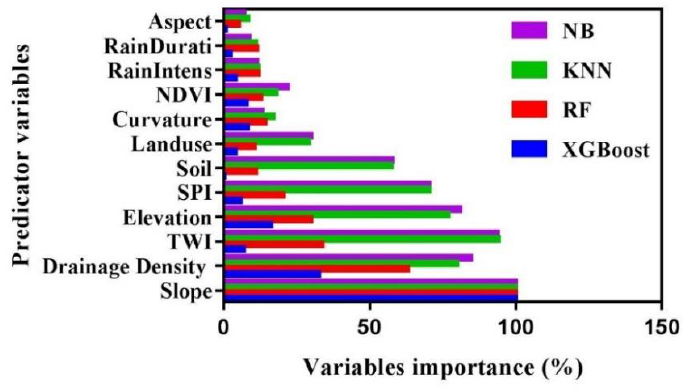
Figure 9. Variable importance of the used models.